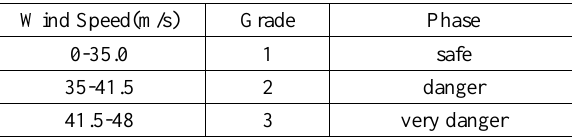
Table 3. The Storm Hazard Risk Grade